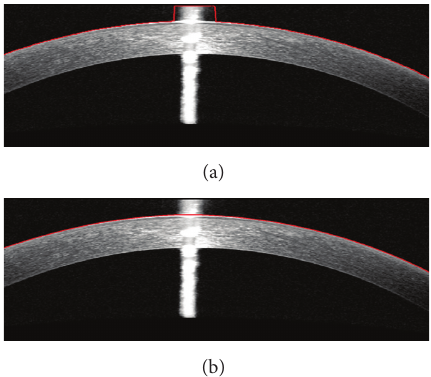
Figure 9: (a) Primary segmentation of Epithelium boundary that has failed in the central artifact. (b) The corrected Epithelium boundary.